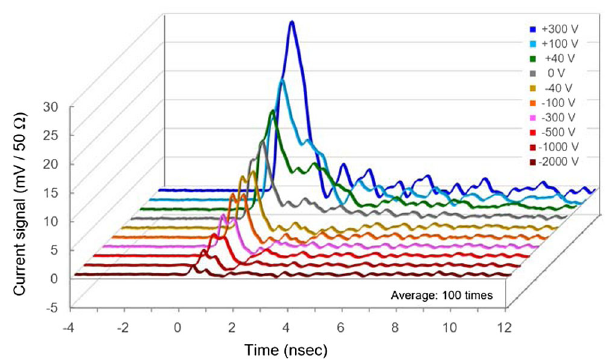
FIG. 18. Variation of pulse waveforms observed by changing the voltage of the charge collecting